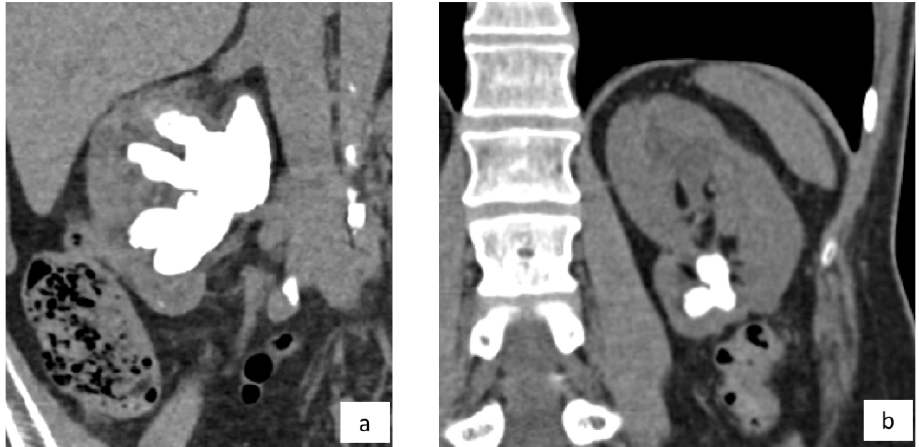
Figure 2. Staghorn calculi on CT scan. ( a ) Complete staghorn stone occupying the whole pyelocaliceal cavities; ( b ) Partial lower pole staghorn calculus.